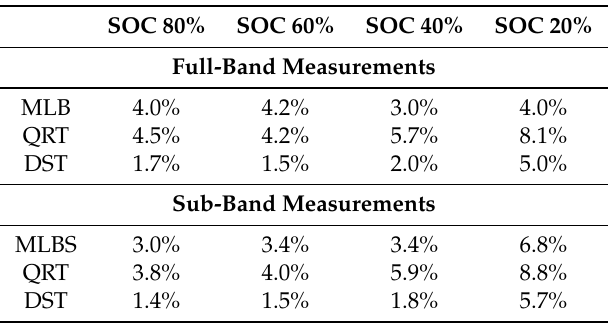
Table 2. NRMSE values of the PRS measurements (EIS as